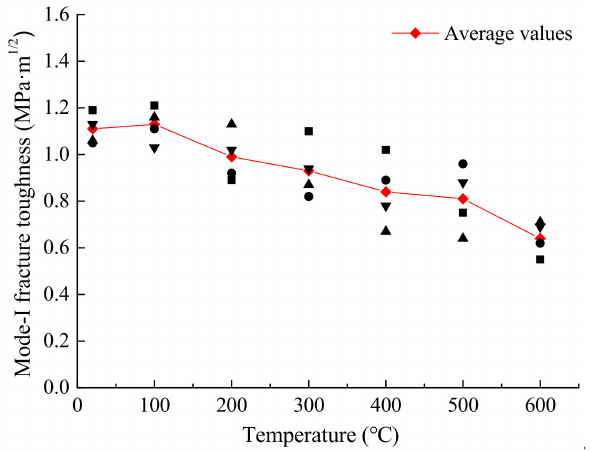
Figure 5. Mode-I fracture toughness of rock vs.